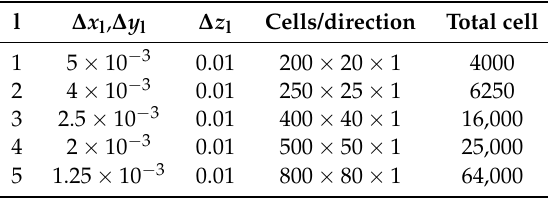
Table 5. Mesh characteristics on different levels l used for the